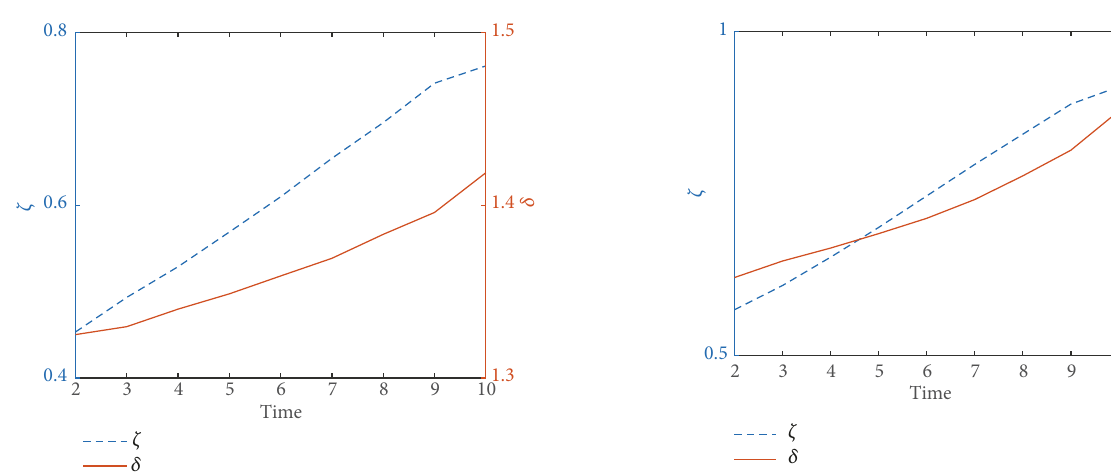
Figure 7: Hedging amounts ( 𝛿 𝑡 , 𝜁 𝑡 ) on MEGB2 returns.